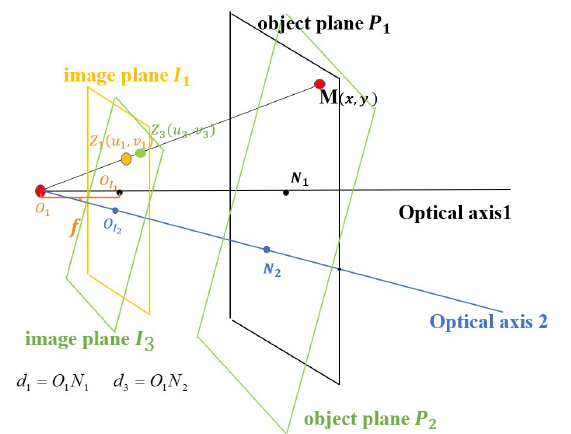
Figure 5. Projection coordinates and related physical quantities corresponding to the object point M when the optical axis rotates with angle ϕ